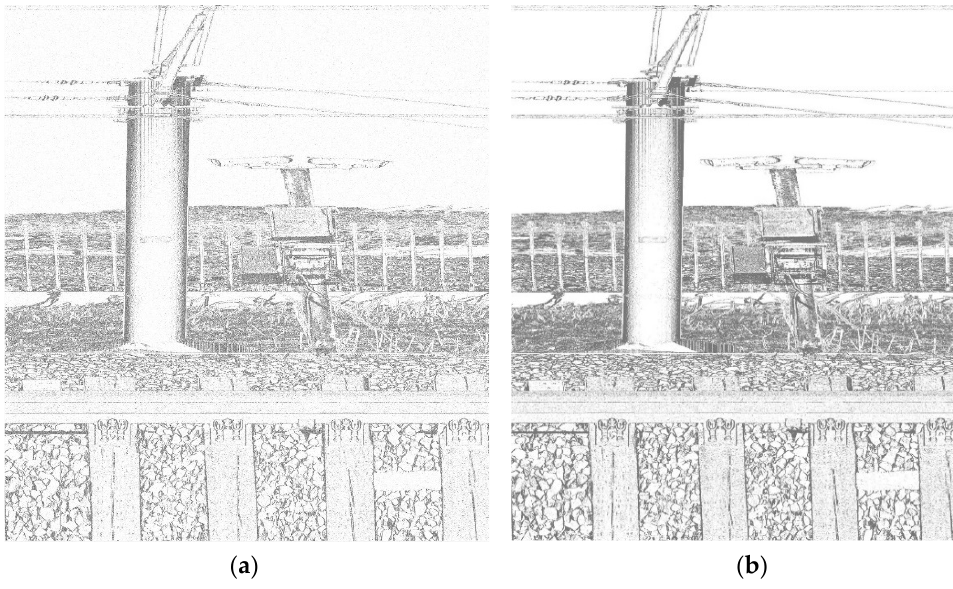
Figure 5. Depth image generated from partial railway point cloud data:( a ) Before adaptive filtering;( b ) After adaptive filtering.